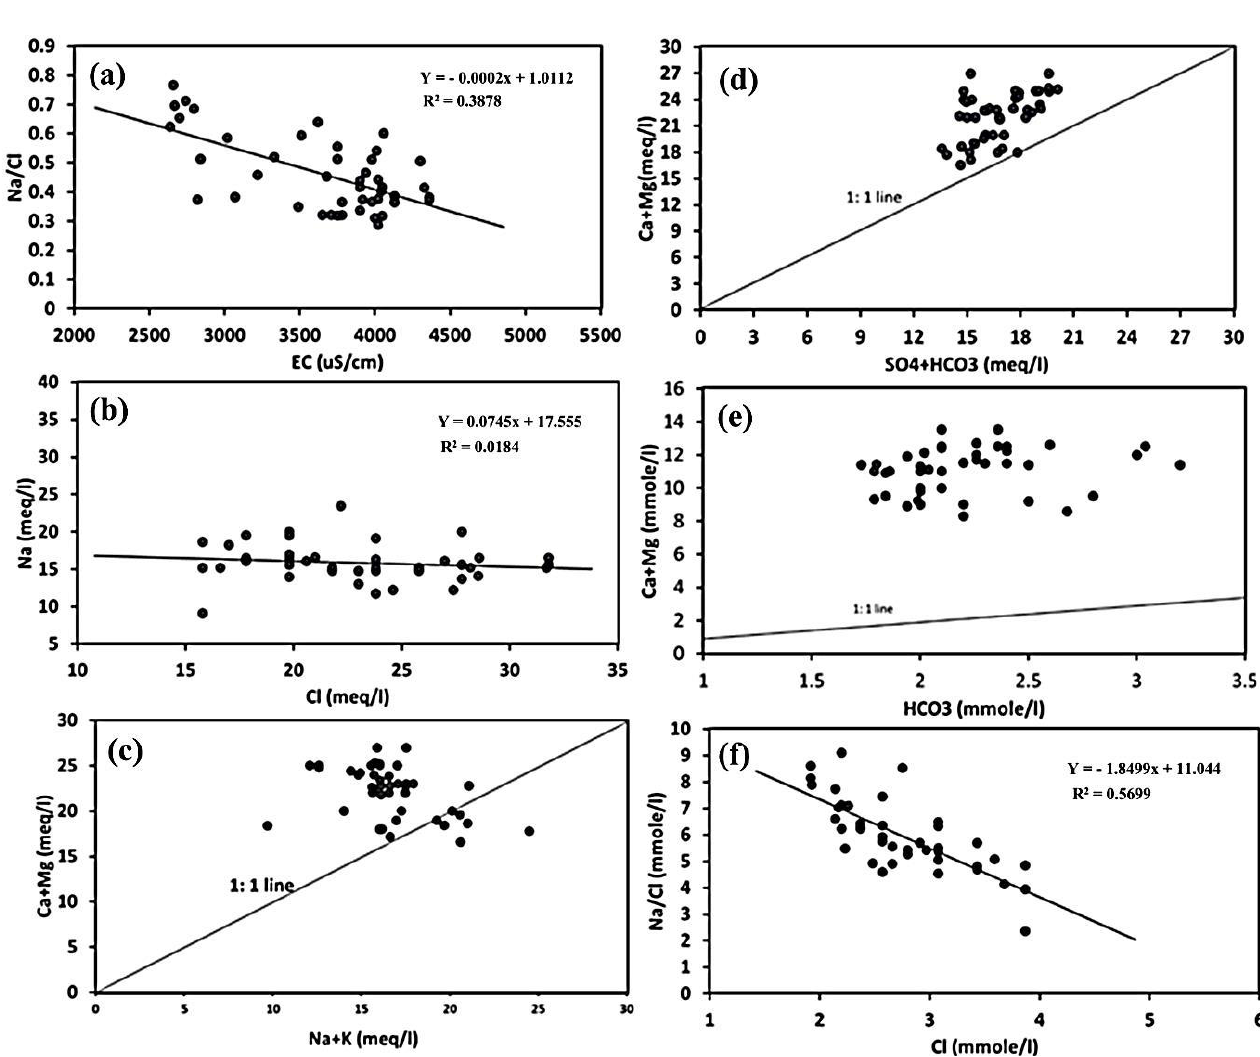
Figure 7. Ionic relationships between the different physicochemical parameters: ( a ) Na + /Cl − and EC; ( b ) Na + and Cl − ; ( c ) Ca 2+ + Mg 2+ and Na + + K + ; ( d ) Ca 2+ + Mg 2+ and SO 42 − + HCO 3 − ; ( e ) Ca 2+ + Mg 2+ and HCO 3 − ; ( f ) Na + /Cl − and Cl − .